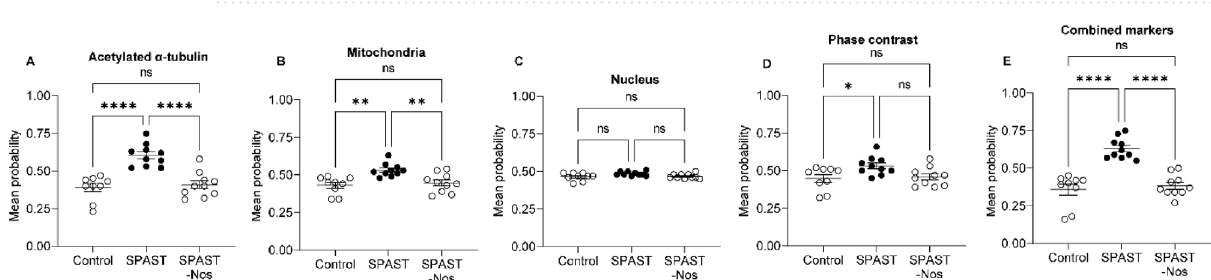
Figure 7. Logistic regression analysis of noscapine-treated SPAST patient cells. We compared noscapine treated SPAST patient cells (33,764 cells from 10 individuals) to untreated control and SPAST patient cells presented above in the SPAST vs controls section (Fig. 3) for comparison. Noscapine-treated SPAST patient cells had logistic regression probability values comparable to controls for all markers: acetylated α-tubulin ( A ), mitochondria ( B ), nucleus ( C ), phase contrast ( D ) and all markers combined ( E ). Mean values were compared using one way